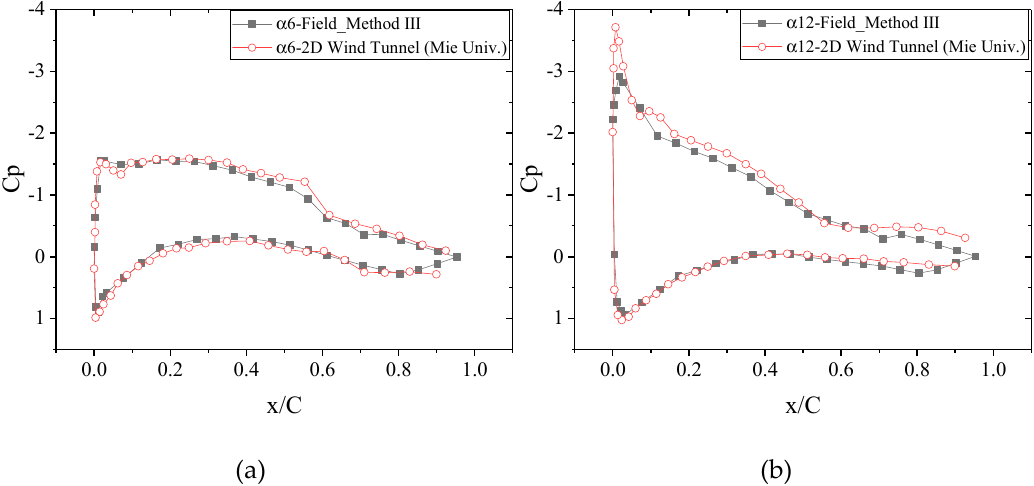
Figure 19. Comparison of pressure coefficients: ( a ) α = 6°, ( b ) α = 12°.